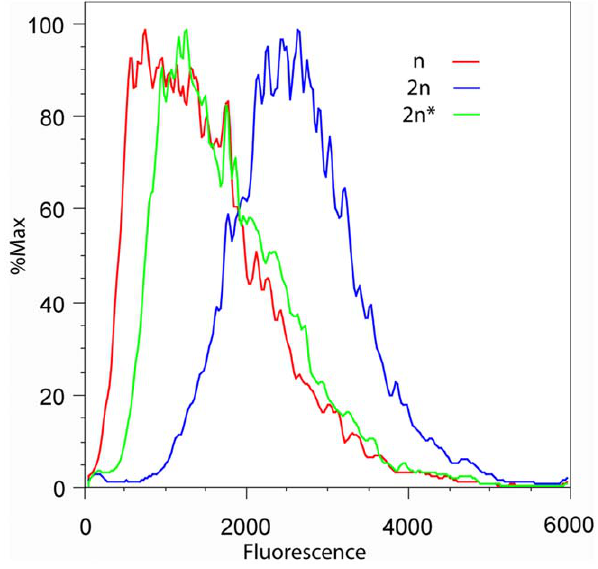
Figure 1. Level of telomeric reporter protein increases in diploids in a mating-type dependent manner. Yeast strains containing a single URA3-yEGFP reporter adjacent to core X at the left end of chromosome XI had fluorescence levels measured by flow cytometry. Histogram plots are for three strains: haploid (n, red), diploid (2n, blue), diploid with MATa deleted (2n*, green).